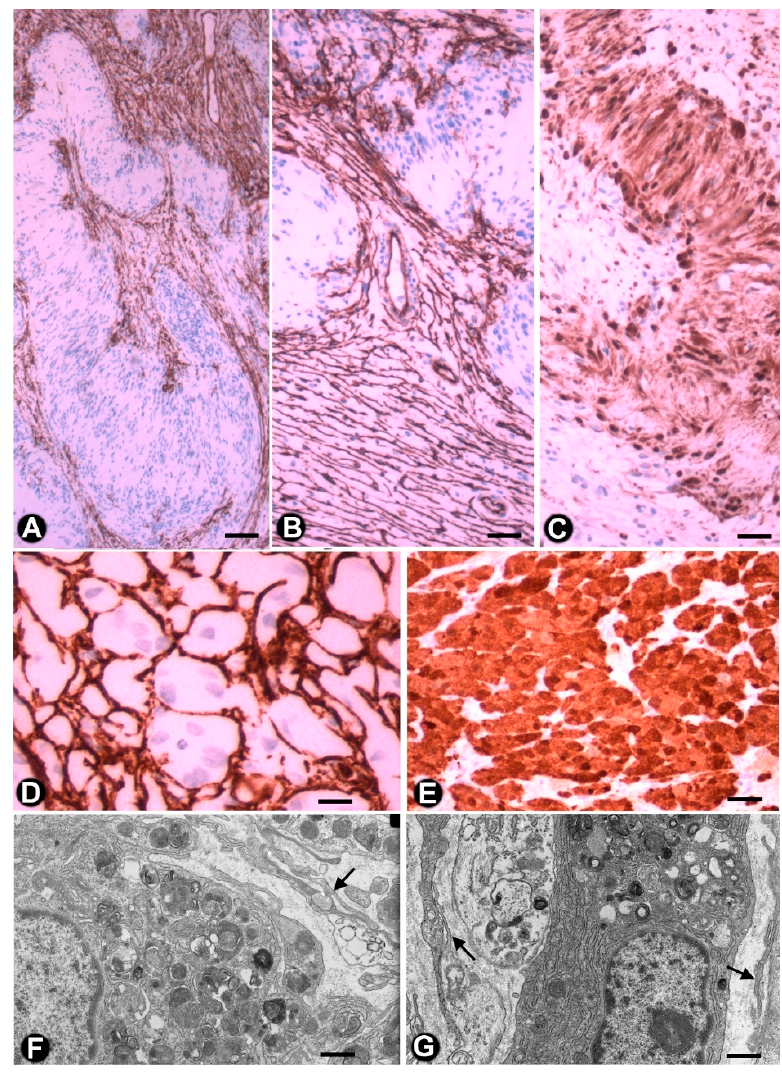
Figure 8. TCs/CD34+SCs in schwannomas and granular cell tumours. ( A – C ) A schwannoma in which numerous TCs/CD34+SCs (brown) (A and B) are arranged around groups of Schwann cells, which form Verocay bodies (A and B) and express S100 (brown) (C). D and E: Granular cell tumour, in which TCs/CD34+SCs) (brown) ( D ) surround granular cells (granular S100-positive Schwann cells) (brown) ( E ). ( F , G ) Ultrastructural characteristics of the granular cells in whose environment some telopodes are observed (arrows). A to E: Sections immunostained with anti-CD34 (brown) (A, B, D) and anti S-100 (brown) (C and E). F and G: Ultrathin sections, Uranyl Acetate and Lead citrate. Bar: A, B, C, E, 80 µm; D, 60 µm; F, G, 0.5 µm.